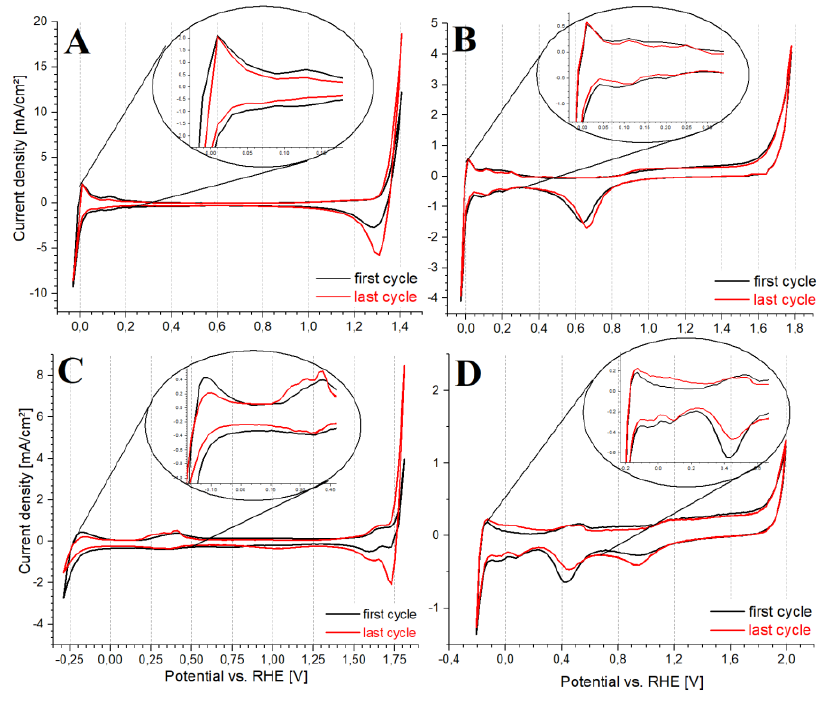
Figure 1. Cyclic voltammograms (CVs) recorded with polycrystalline platinum disk electrode with a surface area of 0.785 cm 2 at 100 mV / s in acidic and neutral media for 24 h of the dissolution study: ( A ) 1 M HCl, reference electrode (RE): Hg / Hg 2 Cl 2 ; ( B ) 0.5 M H 2 SO 4 , RE: Hg / Hg 2 SO 4 ; ( C ) 1 M KCl, RE: Hg / Hg 2 Cl 2 ; ( D ) 0.5 M K 2 SO 4 , RE: Hg / Hg 2 SO 4 .